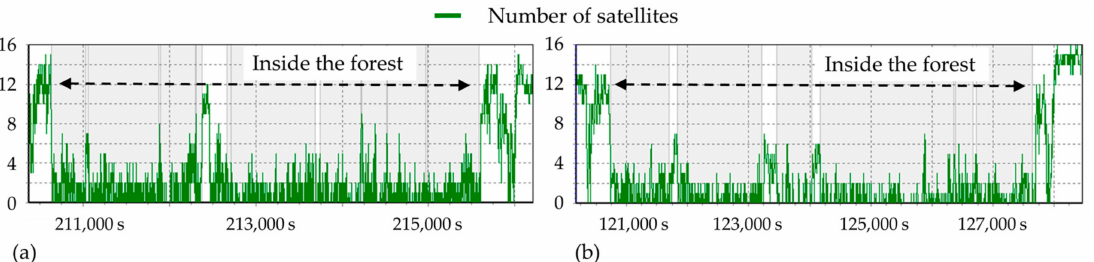
Figure 13. Number of satellites during the MLS recording. ( a ) leaf-off; ( b ) leaf-on.